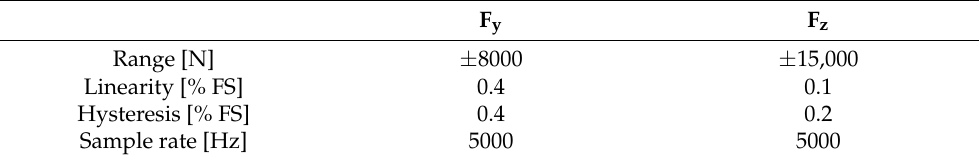
Figure 3. IR sensors layout. Table 1. Kistler RoaDyn P625 calibration certificate.